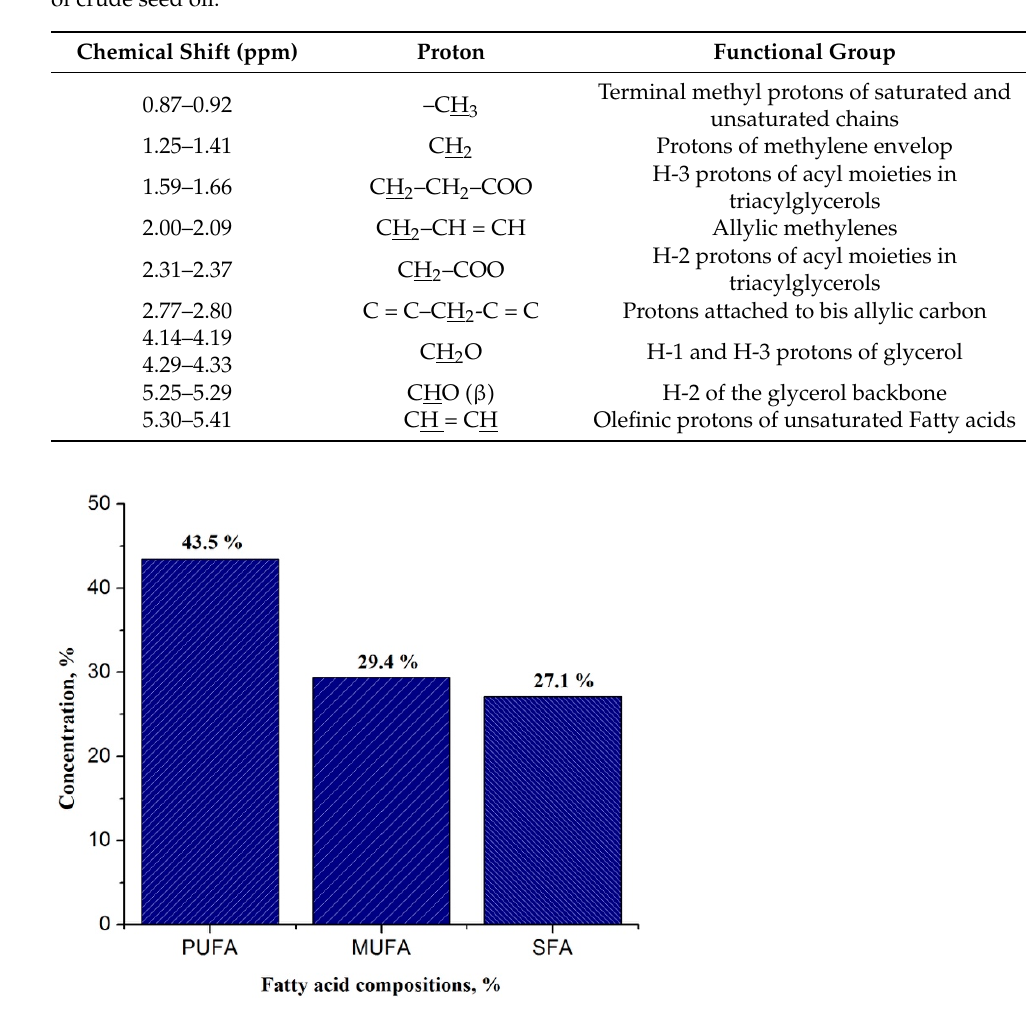
Table 2. Chemical shifts and assignments of the characteristic resonances in the 1 H-NMR spectrum of crude seed oil.